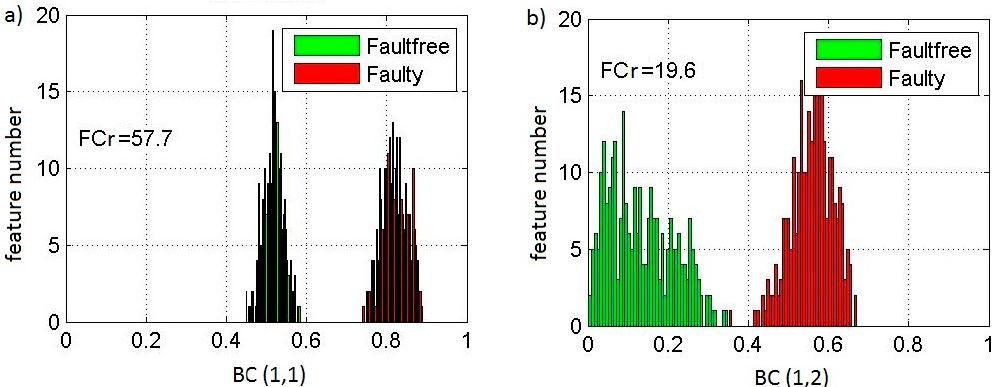
Figure 3. ( a ) The histograms of the magnitudes of the bicoherence BC (1,1); ( b ) The histograms of the magnitudes of the bicoherence BC (1,2).